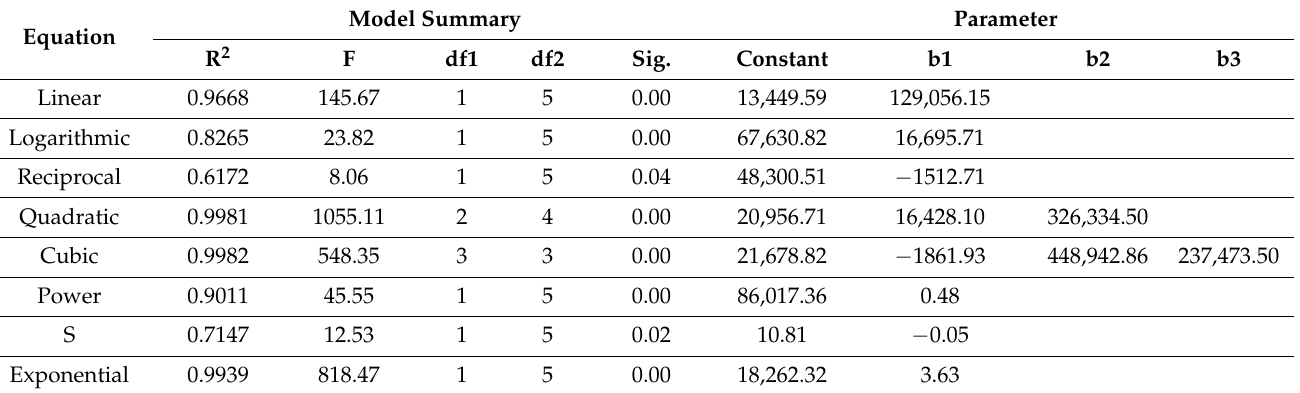
Table 4. Model statistics and parameter